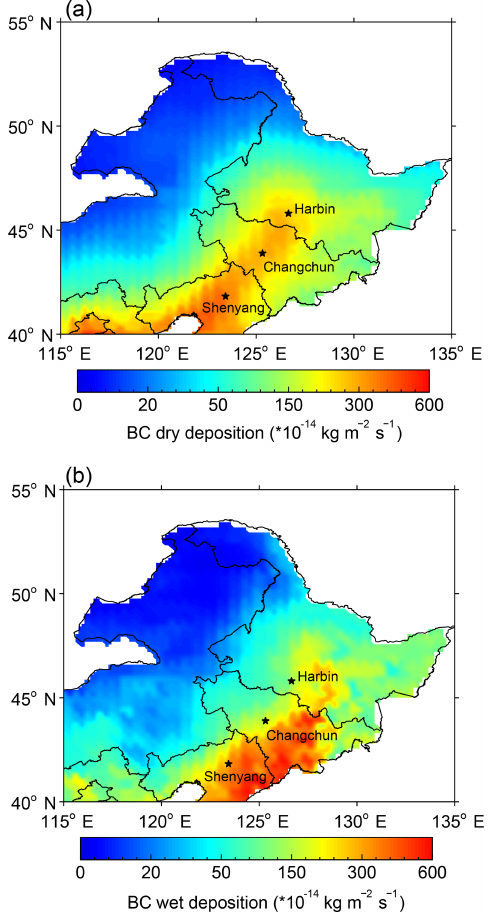
Figure 8. Spatial distribution of average (a) dry and (b) wet depo- sition of BC in NEC in January–February from 2003 to 2017. BC deposition data are from the MERRA-2